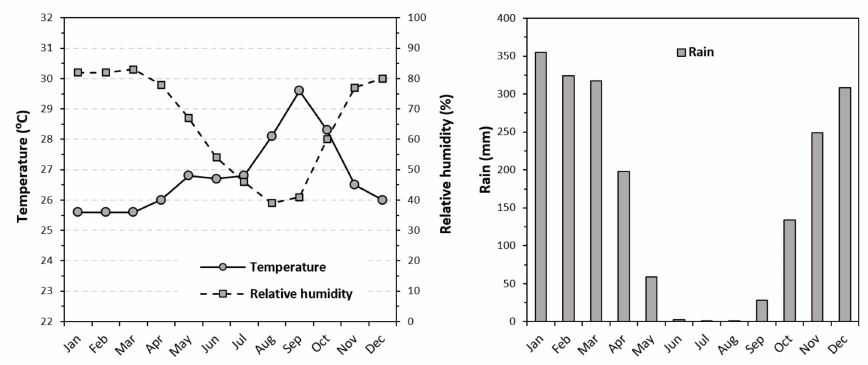
Figure 2. The typical annual ambient conditions of Palmas,